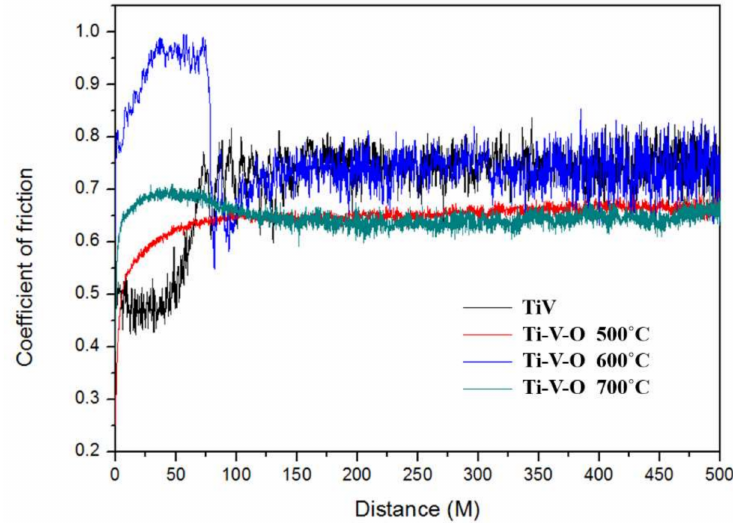
Figure 6. Coefficient of friction (COF) values of the TiV coating and HTA Ti-V-O